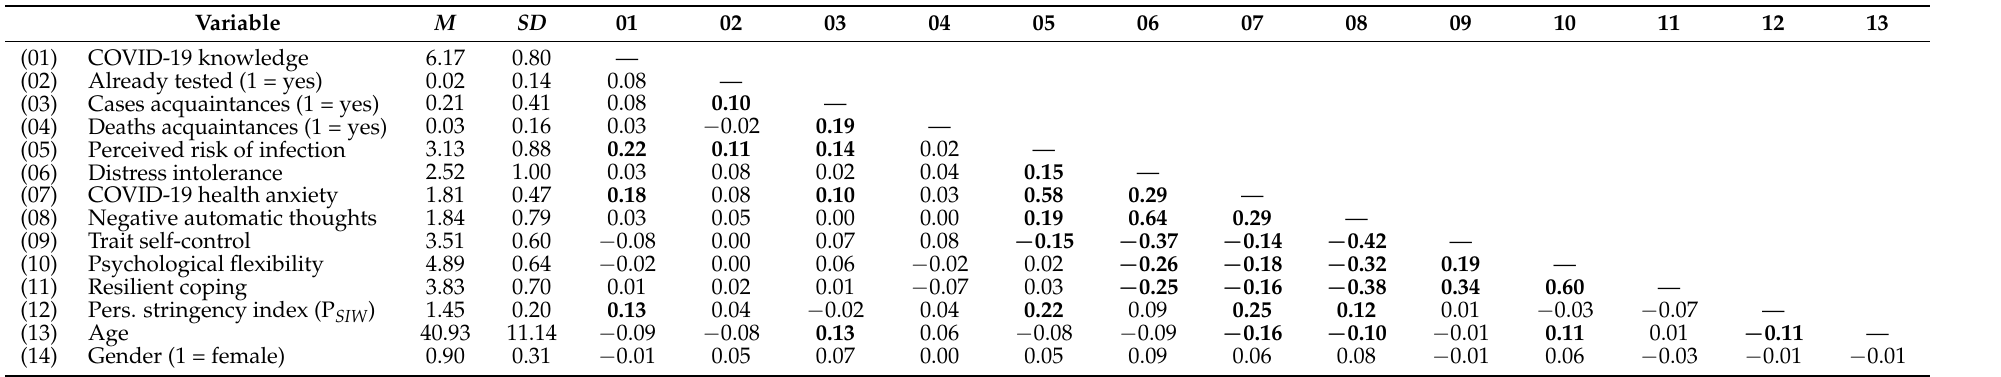
Table 2. Bivariate correlations for study